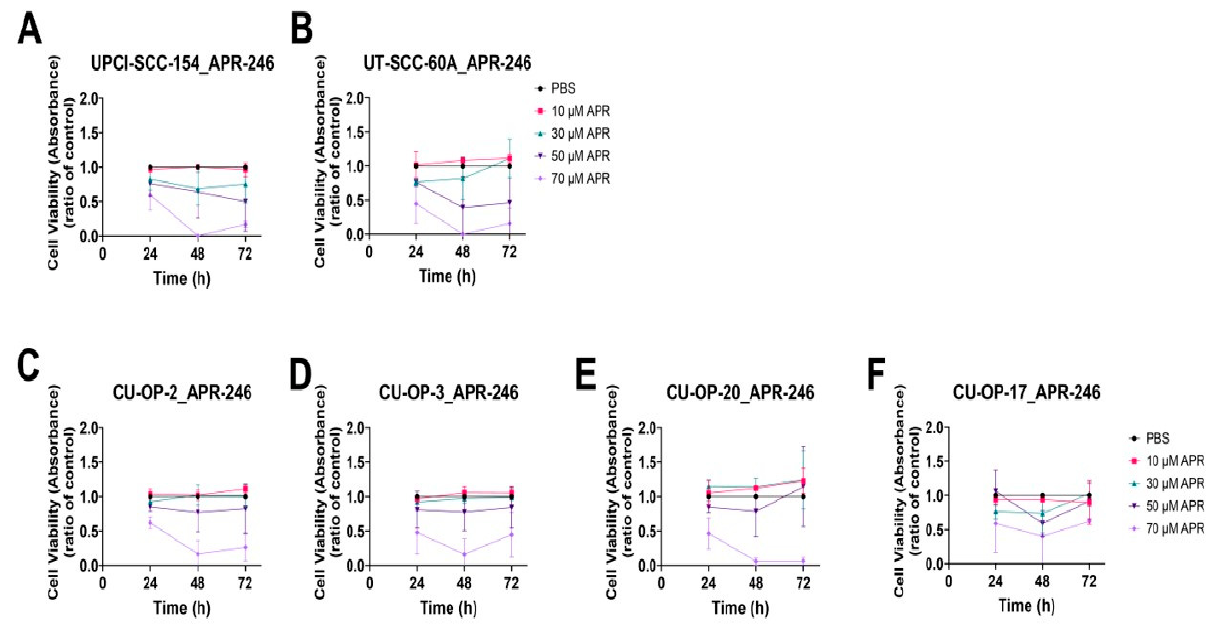
Figure 5. WST-1 viability assay on the HPV + UPCI-SCC-154 and HPV- UT-SCC-60A ( A , B ) and CU-OP-2, -3, -20 and -17 cell lines ( C – F ). Cell viability measured as absorbance after 24, 48, and 72 h of single treatments with APR-246. APR denotes APR-246.